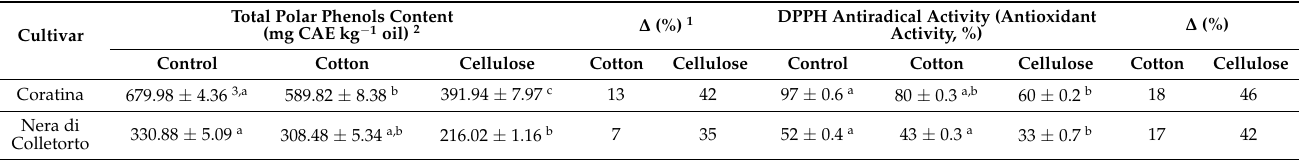
Table 6. Phenolic compounds and DPPH antiradical activity of the EVOO abiotic fraction. Cultivar